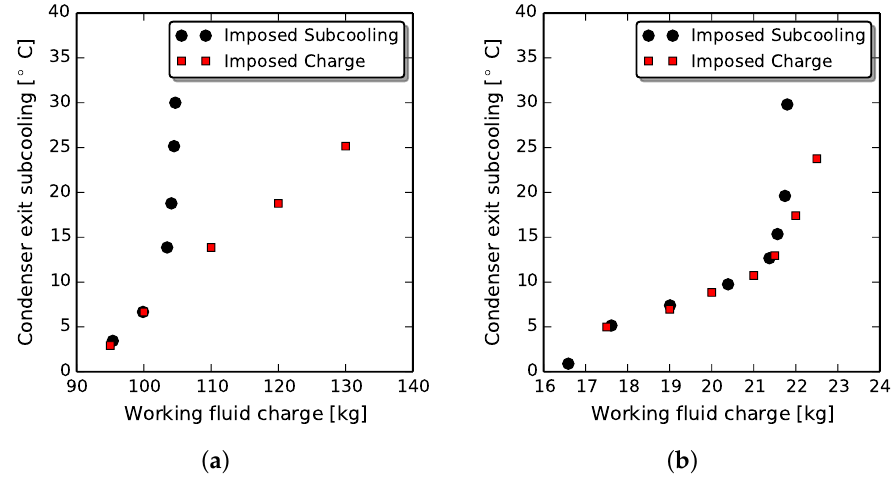
Figure 17. Limitation of the subcooling-based solution scheme on the correct prediction of the total charge of the system: ( a ) ORC with R245fa at Ghent University; ( b ) ORC with R134a at the